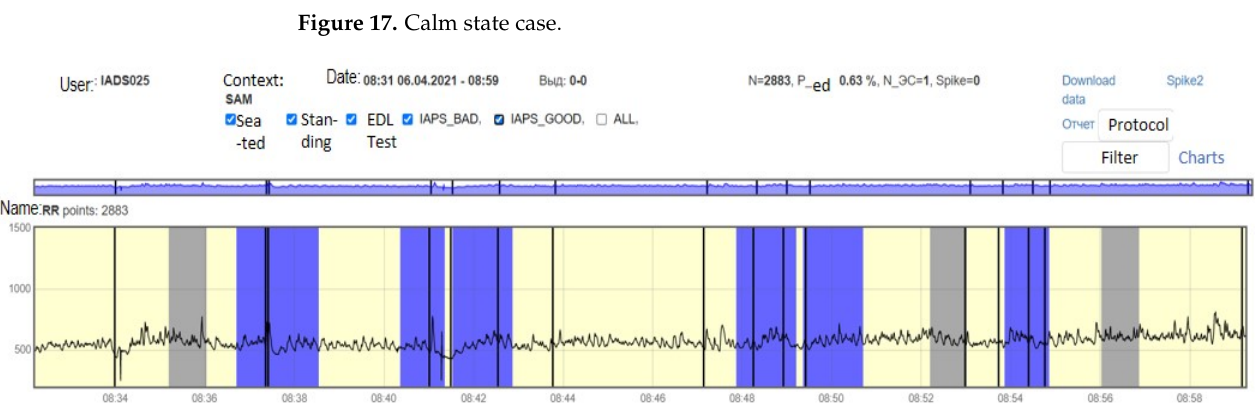
Figure 18. Worsening state case.